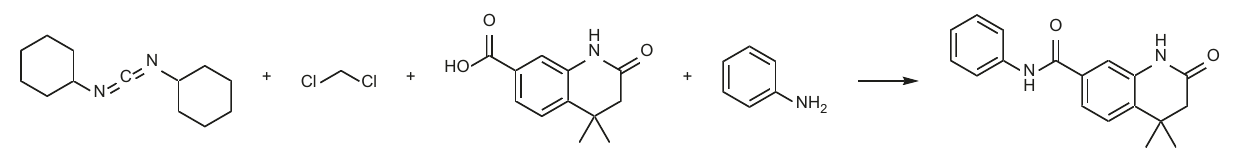
Fig. 2 Illustration of a chemical equation. To the left of the arrow, one can identify all the precursor molecules, while the product molecule is shown to its right. On the left-hand side of the reaction, we also include molecules that play a role as reagents or solvents only, such as the fi rst two entities: N,N ′ -dicyclohexylcarbodiimide